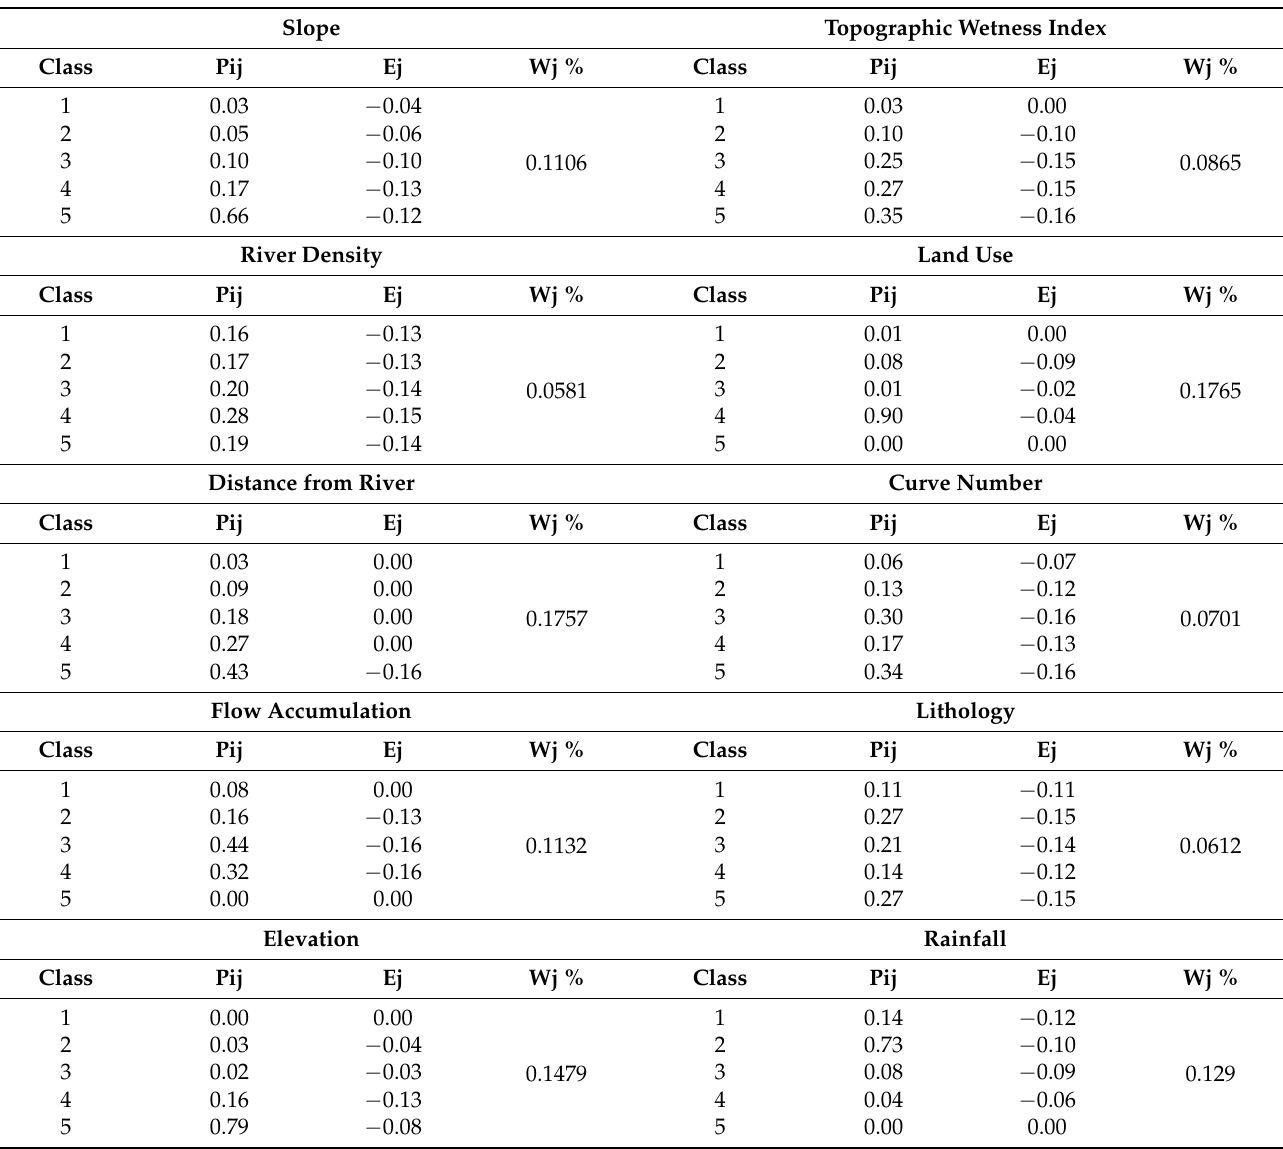
Table 9. Weights given to conditioning factors of SE